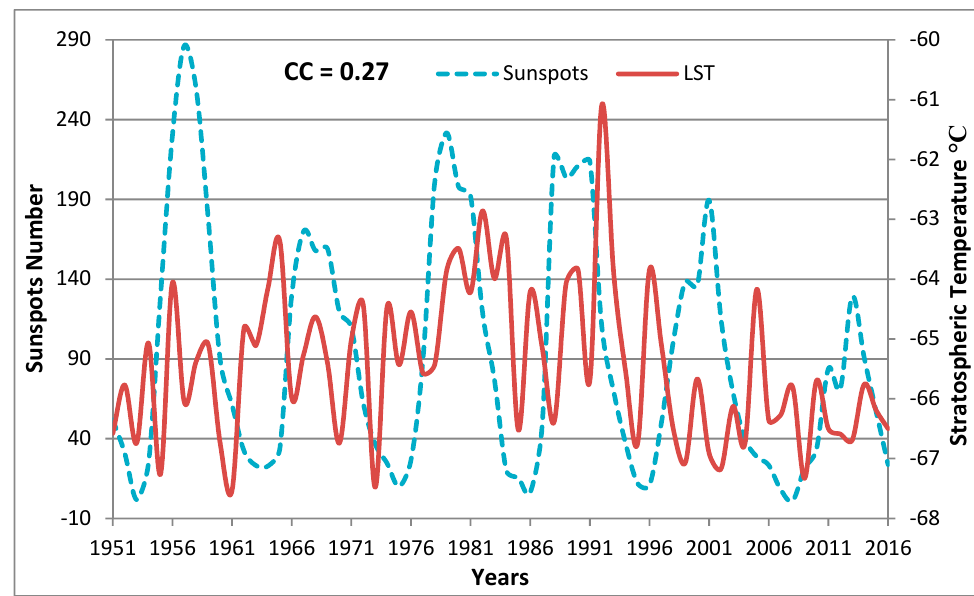
Figure 5. The distribution pattern of the sunspot number and LST time series. The CC represents the correlation coefficient at zero lag, which is significant at the 95% confidence level.